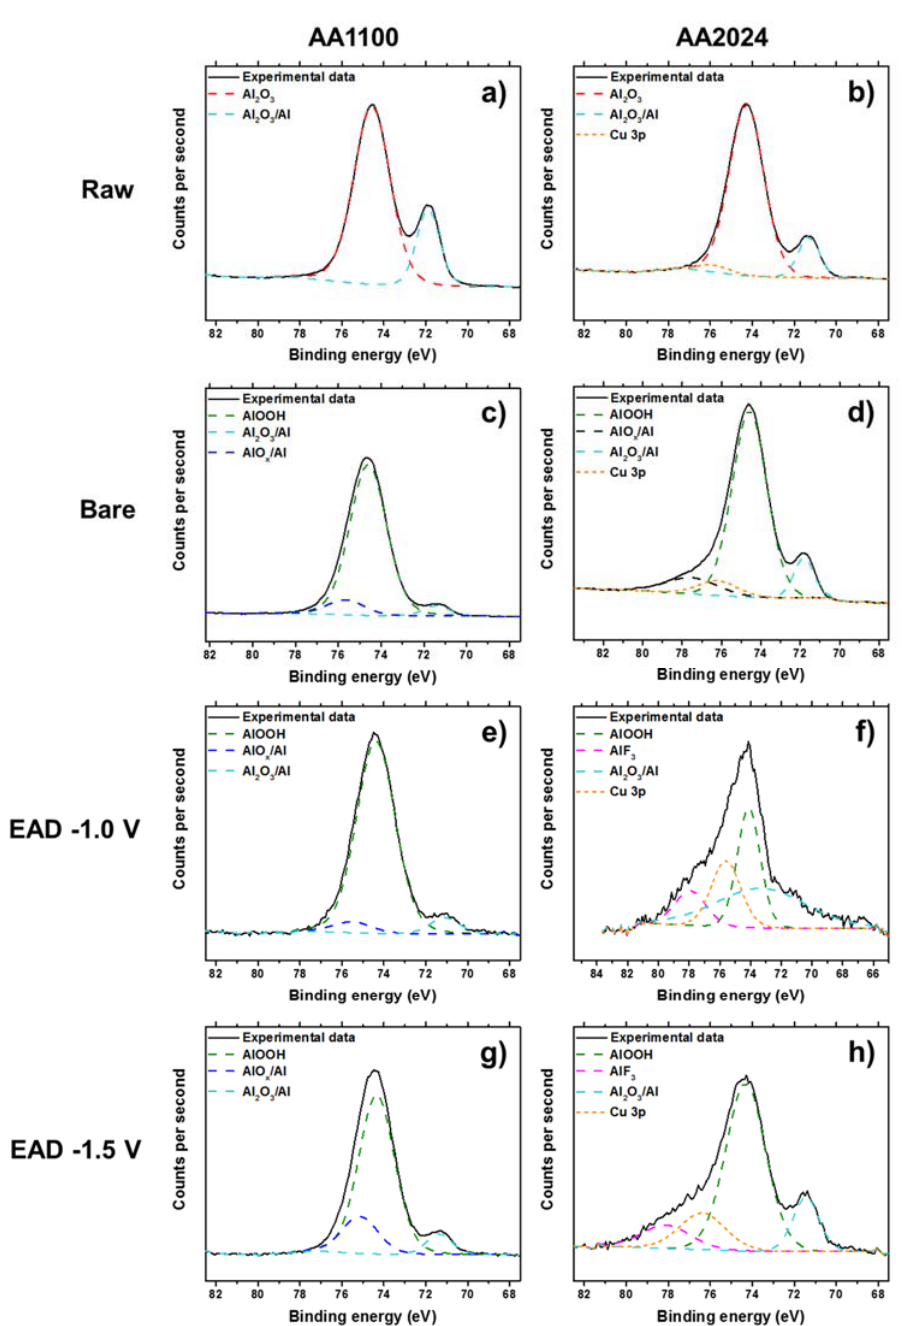
Figure 3. XPS high-resolution spectra of Al 2p region, before (Raw, a , b ) and after alkaline etching process (Bare, c , d ), and after electro-assisted deposition of ZrO 2 , generated at − 1.0 V ( e , f ) and − 1.5 V ( g , h ). Left: AA1100 samples and right: AA2024